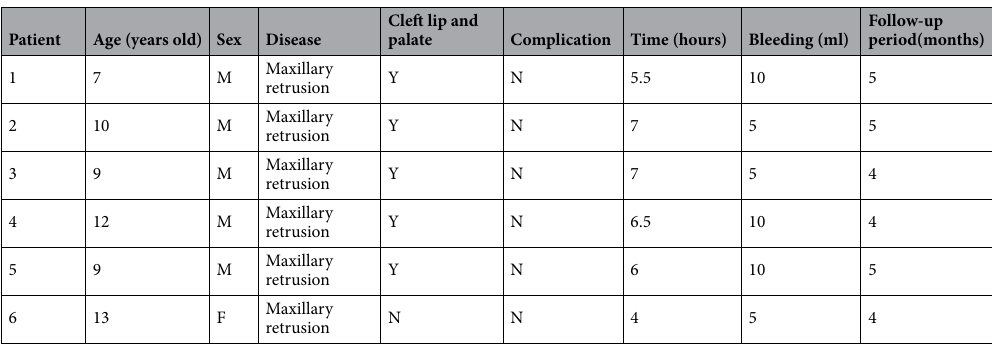
Table 1. Characteristics of the 6 patients included in the study. M male, F female, Y yes, N